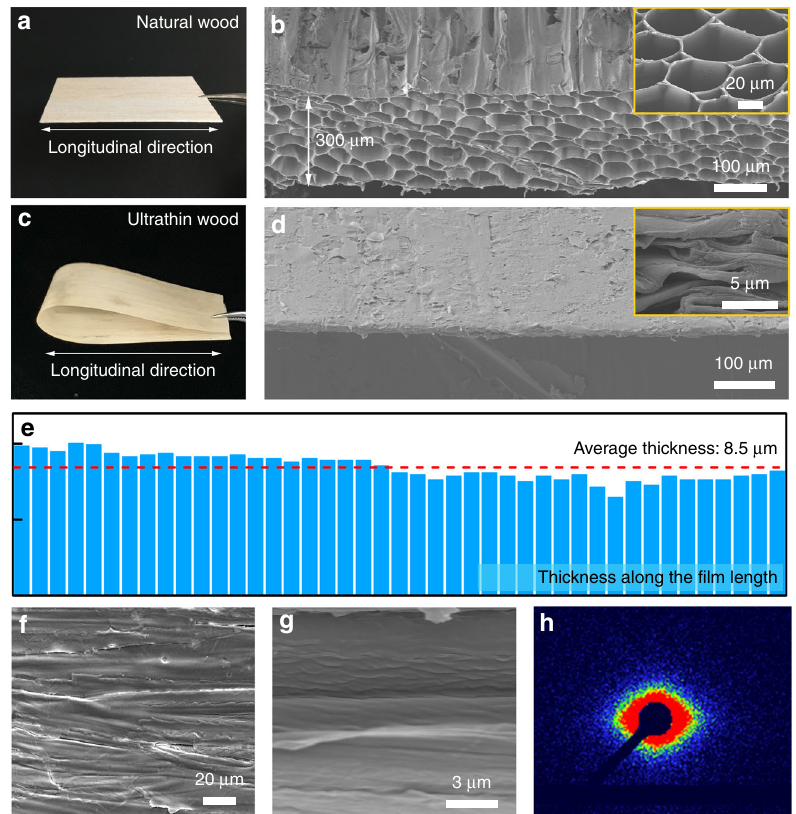
Fig. 2 Morphological characterization of wood fi lms. a Photograph of the rotary cut natural wood. b SEM image of the natural wood, with a thickness of 300 μ m. Inset: top-view SEM image of the natural wood, showing its porous wood structure. c Photograph of the ultrathin wood. d SEM image of the ultrathin wood fi lm, demonstrating its densi fi ed wood structure. Inset: Top-view SEM image of the ultrathin wood, revealing its collapsed wood cell walls. e The measured thickness of the ultrathin wood along its length at intervals of 5 μ m, indicating uniform fi lm thickness. f , g SEM images of the ultrathin wood, showing the aligned cellulose fi bers. h Small-angle XRD pattern of the ultrathin wood, indicating the anisotropic alignment of the cellulose nano fi